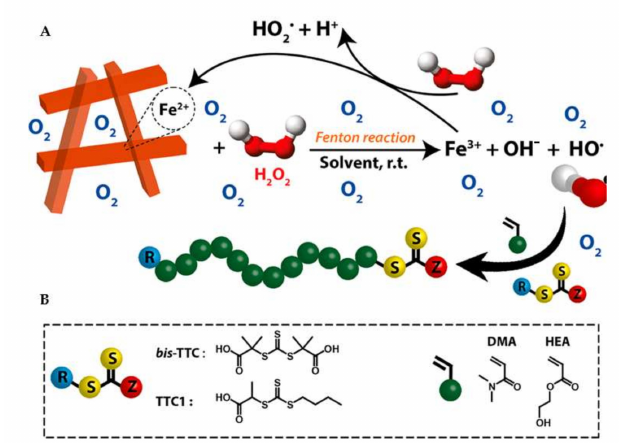
Figure 9. ( A )The mechanismforFenton-RAFTpolymerizationinitiatedby hydroxyl radicals; ( B )Chemical structures of the employed trithiocarbonates (TTCs) and monomers. Copyright 2018, Royal Society of Chemistry